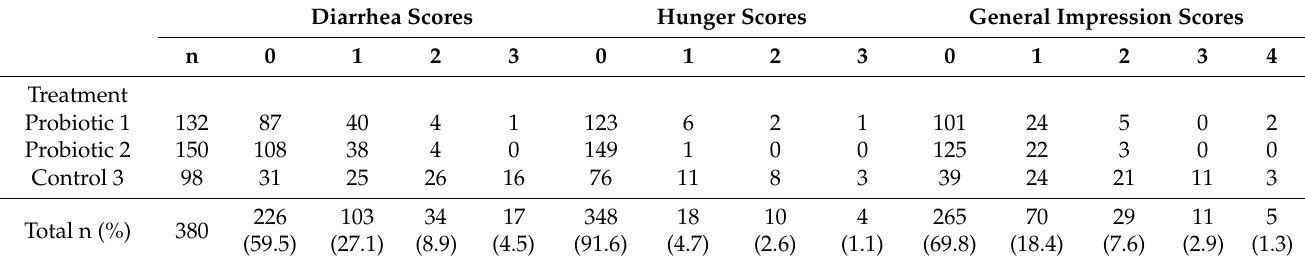
Table 5. Diarrhea, hunger, and general impression scores by treatment group and study day in dairy calves supplemented with two probiotic products to reduce Clostridium perfringens .